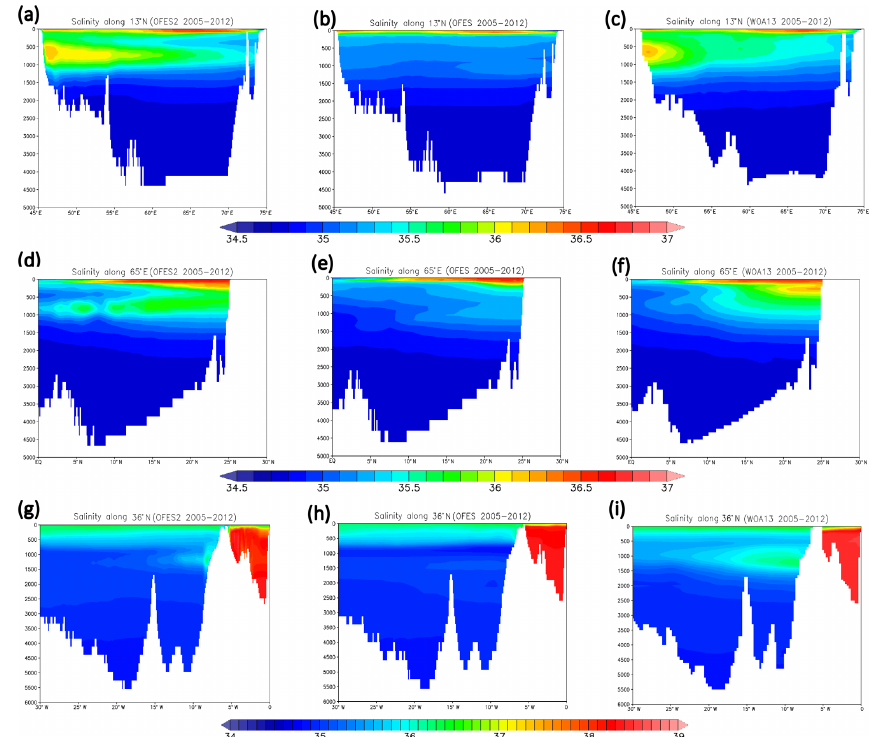
Figure 7. Vertical sections of mean salinity along (a–c) 13 ◦ N and (d–f) 65 ◦ E in the Arabian Sea and (g–i) 36 ◦ N in the eastern Atlantic Ocean averaged over 2005–2012: (a, d, g) OFES2, (b, e, h) OFES, and (c, f, i) WOA13.